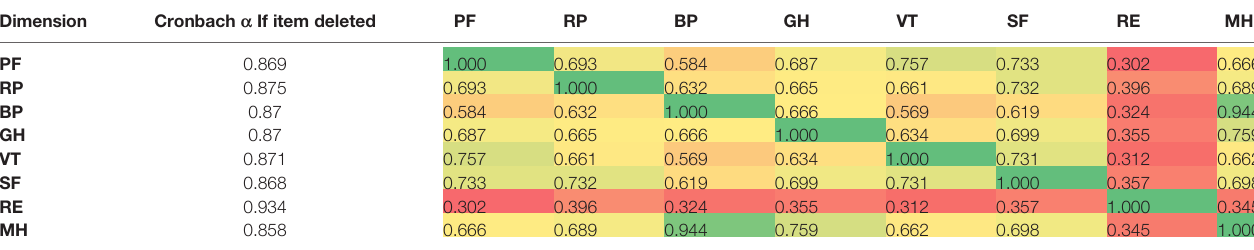
TABLE 3 | SF-12 scale Cronbach a and correlation coef fi cient of different dimensions. Dimension Cronbach a If item deleted